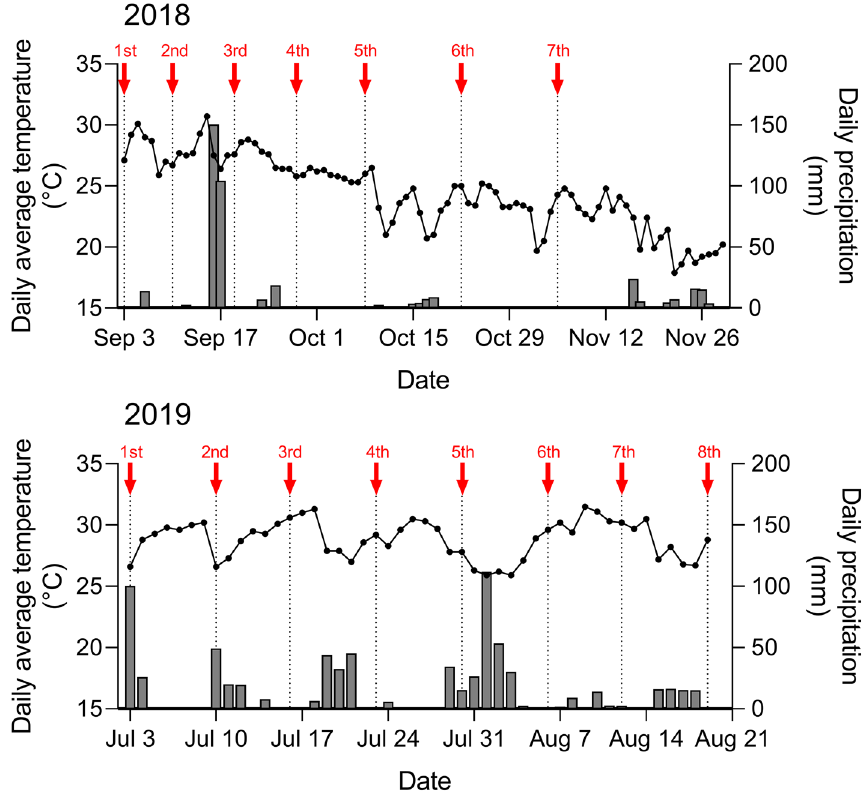
Figure 4. Daily average temperature and daily precipitation in 2018 and 2019 during the resin tapping period. The resin tappings are indicated with red arrows. Data were obtained from the China Meteorological Data Network (http:// data. cma. cn) choosing the Taishan meteorological station. The bar plot represents the daily precipitation, and the line graph represents the daily average